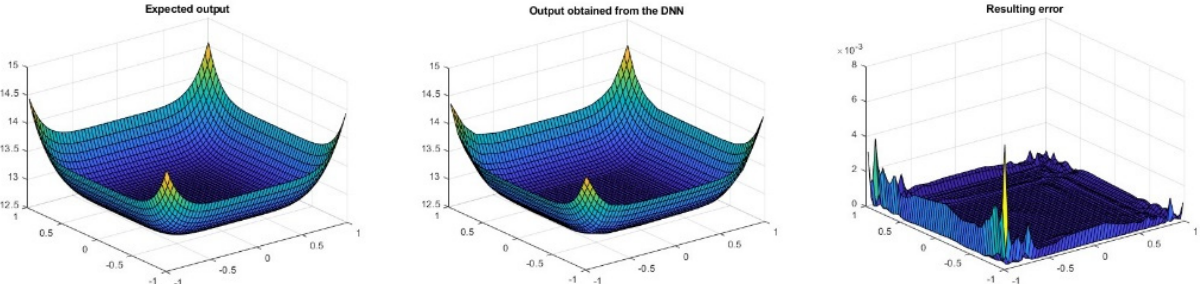
Figure 30. Expected output of the DNN for the De Jong function on the left, the obtained results in the middle and the error on the right.